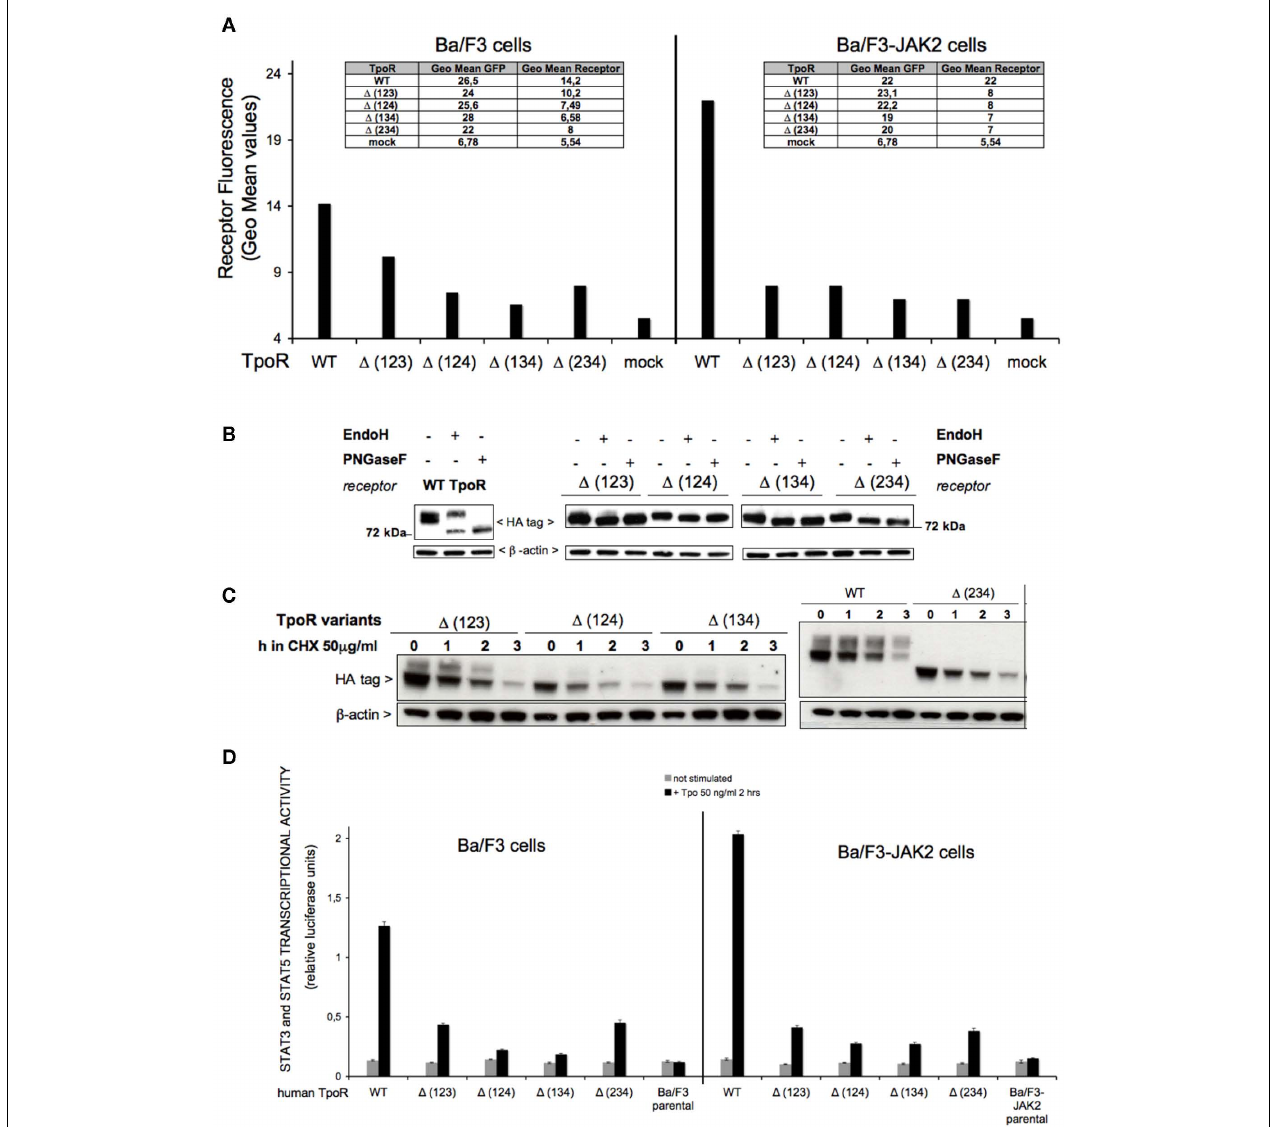
were probed with anti-HA and anti- β -actin. Similar results were obtained in two different experiments. (C) A pool of each cell line used in (A) was treated at 37˚C with 50 μ g/ml cycloheximide (CHX) over different time periods then lysed.The lysates were analyzed forTpoR variants stability using anti-HA and normalized by anti- β -actinWestern blotting. (D) Ba/F3 or Ba/F3-JAK2 cells stably expressing each humanTpoR defective in three N-glycosylation sites were starved 3h in RPMI medium + 1mg/ml BSA and electroporated with the pGRR5-luc and pRLTK-luc reporters.The cells were stimulated with 50ngTpo/ml or left unstimulated 2h at 37˚C. Upon treatment, the cells were lysed and their luminescence recorded. Results are the mean ± variation of triplicate samples. One of three independent experiments is depicted.The t -test showed statistically significant differences forTpo-dependent transcriptional activity levels of the all the TpoR variants, when compared with theWTTpoR (all the p values < 0.0001).